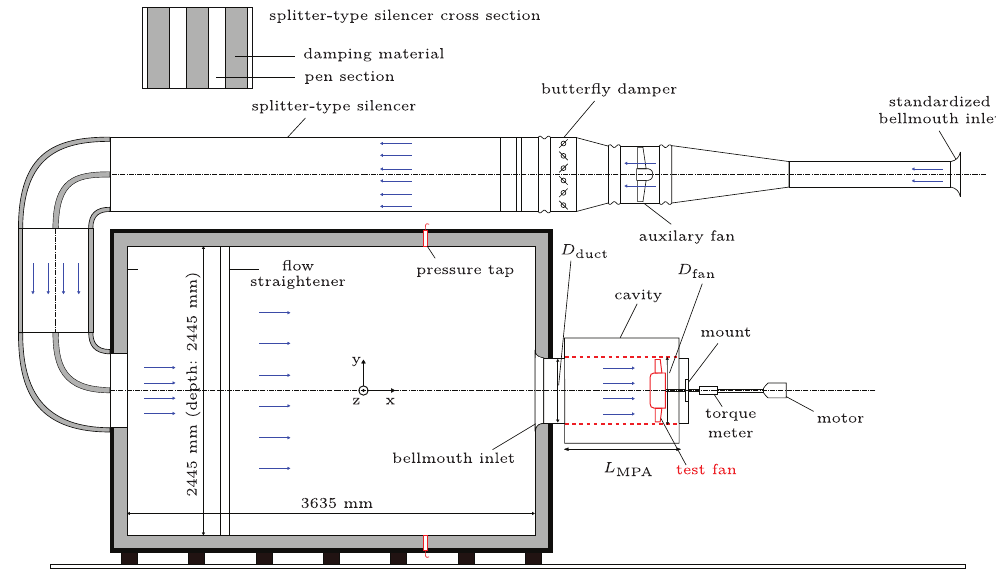
Figure 7. Inlet test chamber designed according to ISO 5801